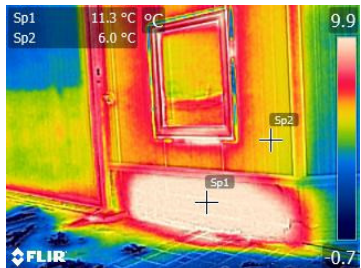
Figure 4. Lack of insulation of the outer envelope in front of the radiator.